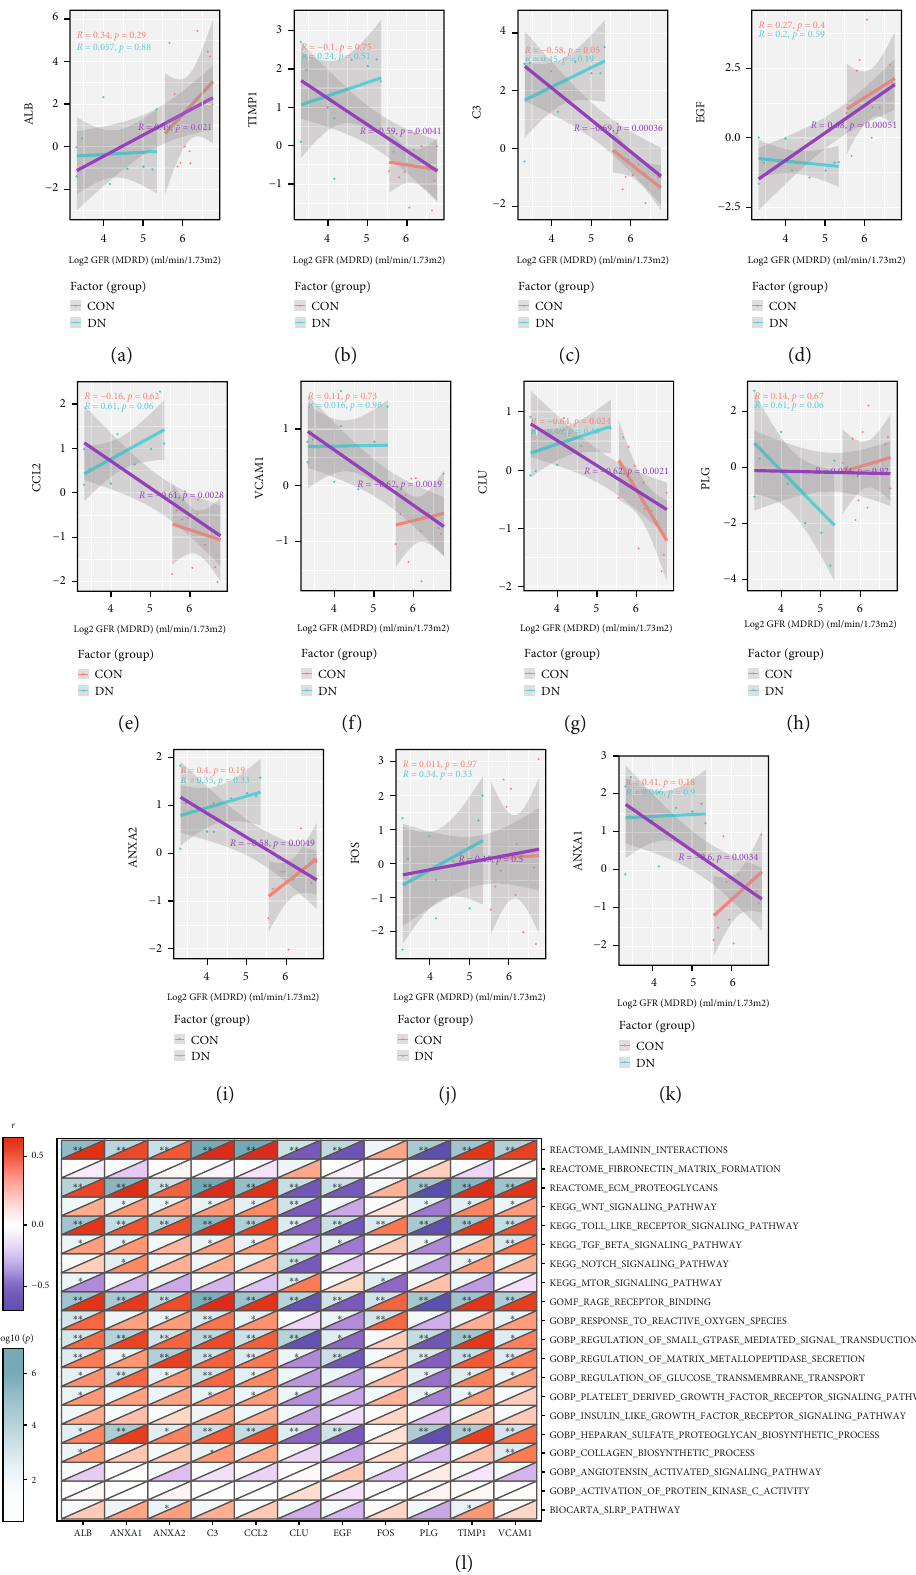
Figure 6: Correlation between ECM-related pathways, GFR, and key genes in DN. The expression of (b) TIMP1, (c) C3, (e) CCL2, (f) VCAM1, (g) CLU, (i) ANXA2, and (k) ANXA1 was reversely correlated with GFR. (l) Many key genes show signi fi cant correlation with the ECM-related